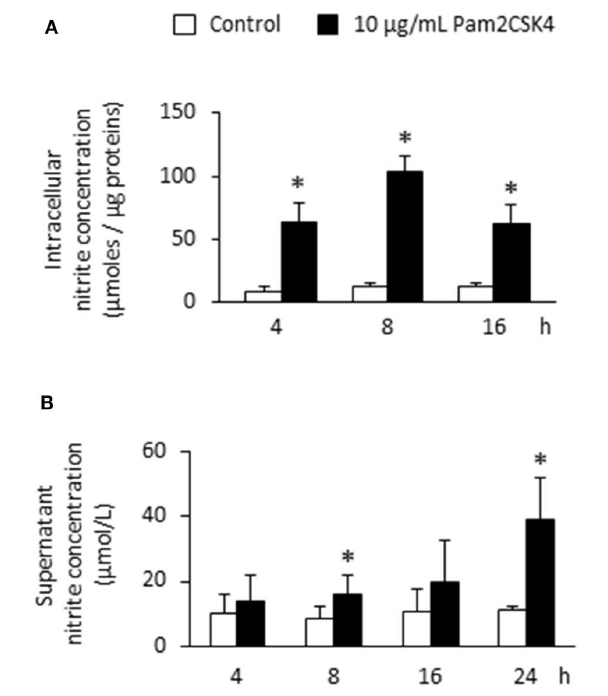
FIGURE 2 | Pam2CSK4 increases NOS activity and extracellular NO production by odontoblast-like cells. (A) Analysis of intracellular NO by the measurement of nitrite concentration in cells stimulated with 10 µ g/mL Pam2CSK4 for the indicated times. Production of intracellular nitrite was strongly increased in PAM2CSK4-stimulated samples, being maximal after 8h ( n = 5 ). (B) Determination of NO concentration in culture supernatants of odontoblast-like cells stimulated with 10 µ g/mL Pam2CSK4. Nitrite progressively accumulated in the culture medium, reaching a concentration of approximately 40 µ mol/L after 24h of stimulation ( n = 5 ). * p < 0 . 05